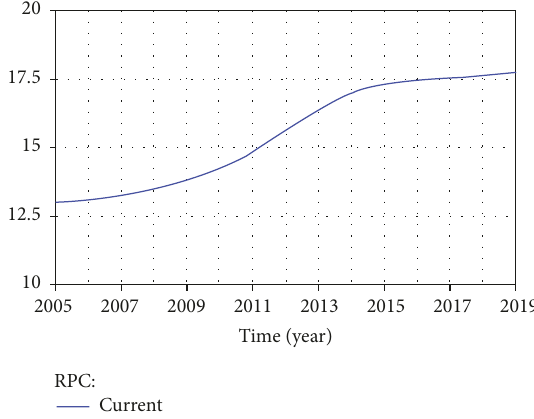
Figure 9: Relationship justice (RJ) trends.